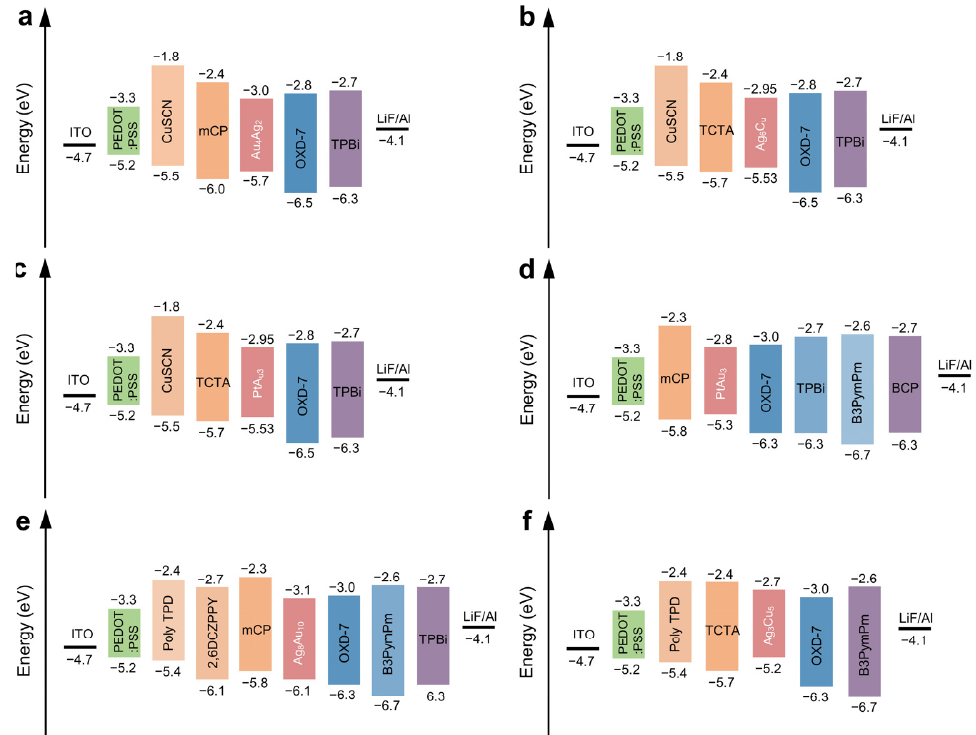
Figure 8. The energy level diagrams of heterometallic NCs. ( a ) The energy level diagram of Au 4 Ag 2 NCs-LEDs. Copyright (2015) Wiley-VCH. ( b ) The energy level diagram of Ag 6 Cu NC LEDs. Copyright (2016) Royal Society of Chemistry. ( c ) The energy level diagram of PtAu 3 NC LEDs. Copyright (2018) Royal Society of Chemistry. ( d ) The energy level diagram of tetraphosphine-PtAu 3 NC LEDs. Copyright (2019) Royal Society of Chemistry. ( e ) The energy level diagram of Ag 8 Au 10 NC LEDs. Copyright (2020) American Chemical Society. ( f ) The energy level diagram of Ag 3 Cu 5 NC LEDs. Copyright (2021) American Chemical Society.